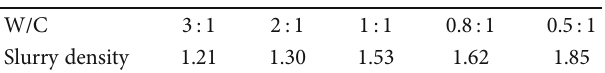
Figure 4: Particle size analysis of the wet-ground cement particles. Table 3: Relationship between water-cement ratio (W/C) and the unit of slurry density.